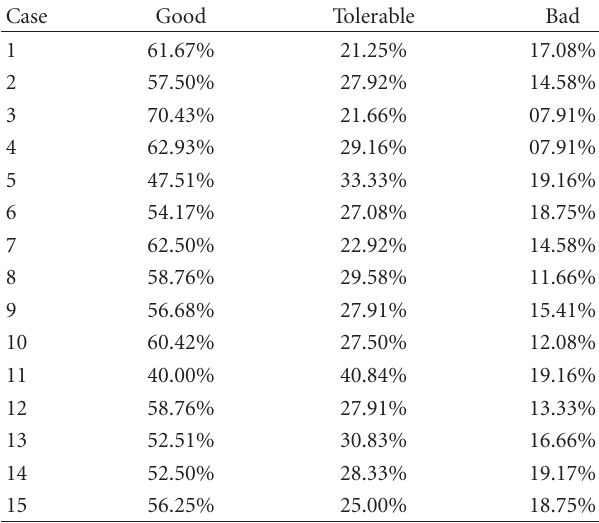
Table 1: Means of validated cases (percentage of slices belonging to each category) by three